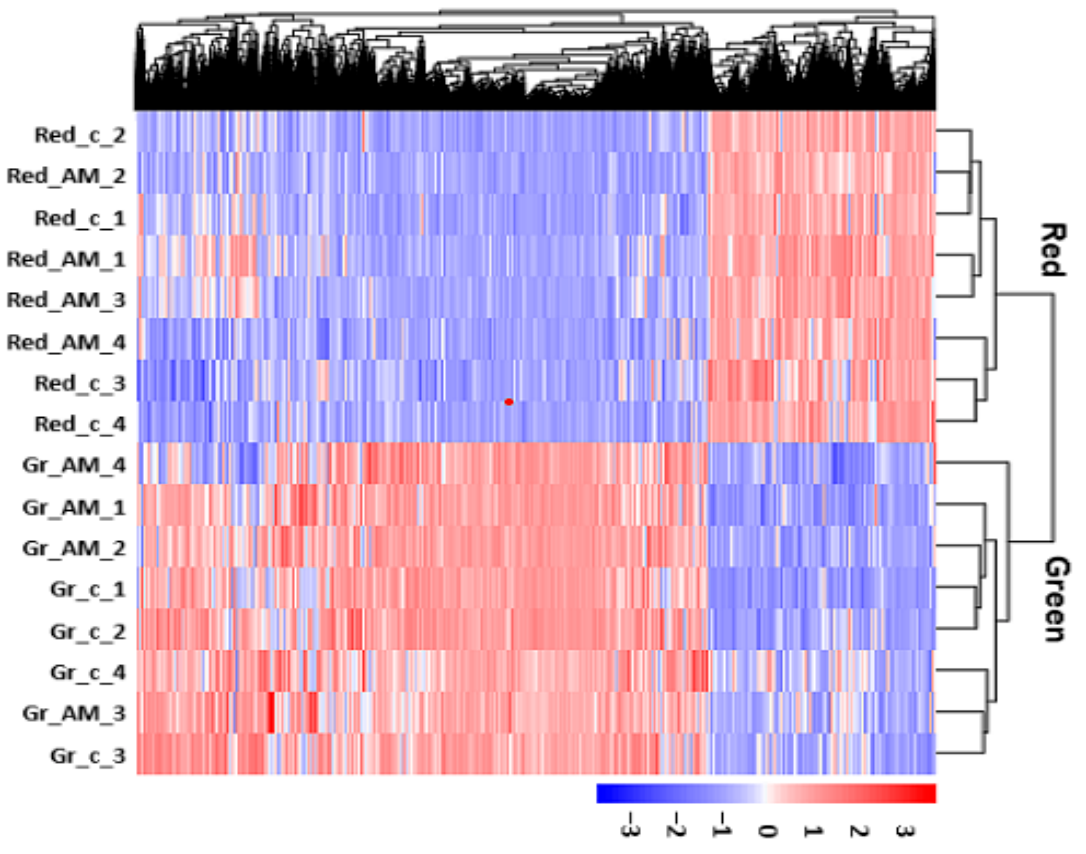
Figure 1. Heatmap displaying differentially expressed genes in hierarchical clusters (DEGs). Clustering was carried out utilizing the log10 (FPKM + 1) values of differentially expressed genes (DEGs) between green and red fruits of both mycorrhizal (AM) and non-mycorrhizal (c) plants ( n = 4, p ≤ 0.05). The Z score of the gene is column-scaled, and the colors represent range from low (blue) to high (red).